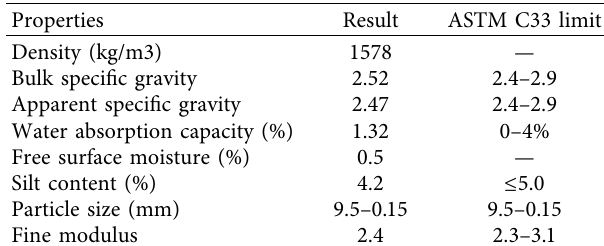
Table 2: Physical properties of fine